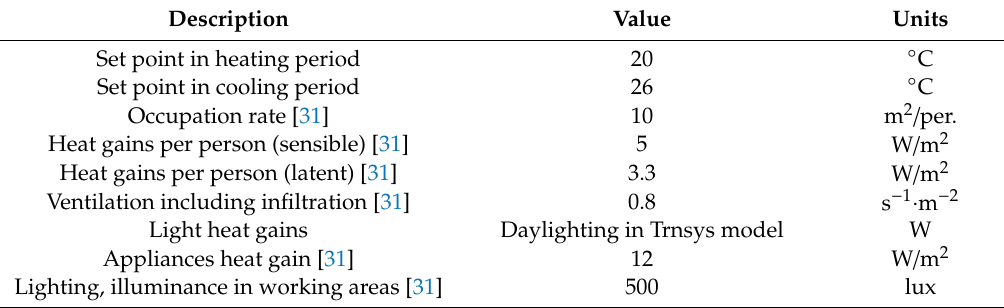
Figure 6. Monthly irradiances at the south façade for Barcelona and Paris. 3.4. Simulation Criteria The purpose of this document is to analyze the thermal, electrical, and lighting behaviors when incorporating the different systems as a substitute for conventional windows. Concerning lighting, daylight availability describes the light transmitted through a window system to an indoor space. It can be defined by dynamic/climate-based metrics such as daylight autonomy (DA), useful daylight illuminance (UDI), or annual light/sunlight exposure [33]. DA is a climate-based metric defined as the percentage of occupied hours in a year when a minimum illuminance threshold (x lux) can be met by daylight alone. Illuminances of 300 lux (DA300 lux) and 500 lux (DA500 lux) are the most common target thresholds for offices, classrooms, and libraries. For any given point in a building, daylight is considered sufficient if the daylight autonomy exceeds 50% of the occupied hours of the year (i.e., DA300 lux or 500 lux > 50%) [33].